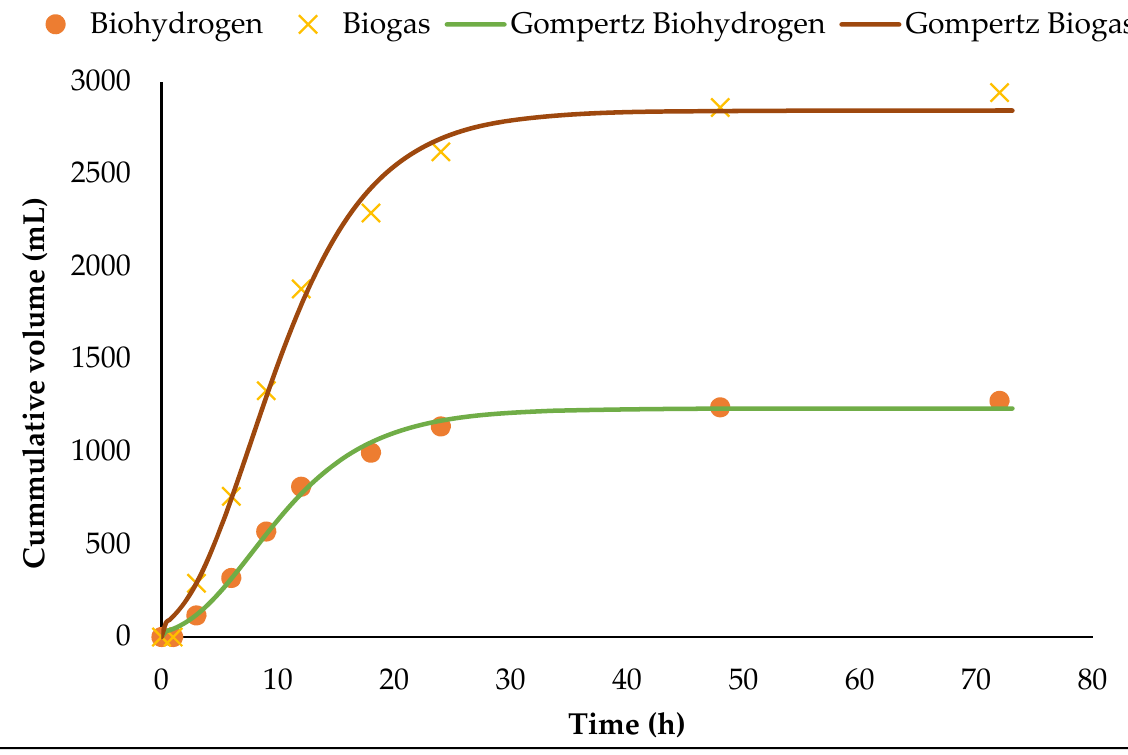
Figure 5. Gompertz curve fitting graph of biogas and biohydrogen evolved at initial pH 9 and substrate level 7.0 g/L of DAA Molasses in 1.5 L ACBR.